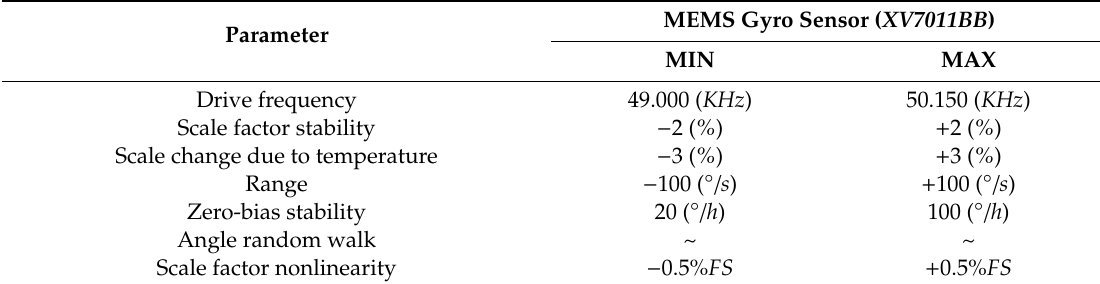
Table 4. Parameters of the gyro